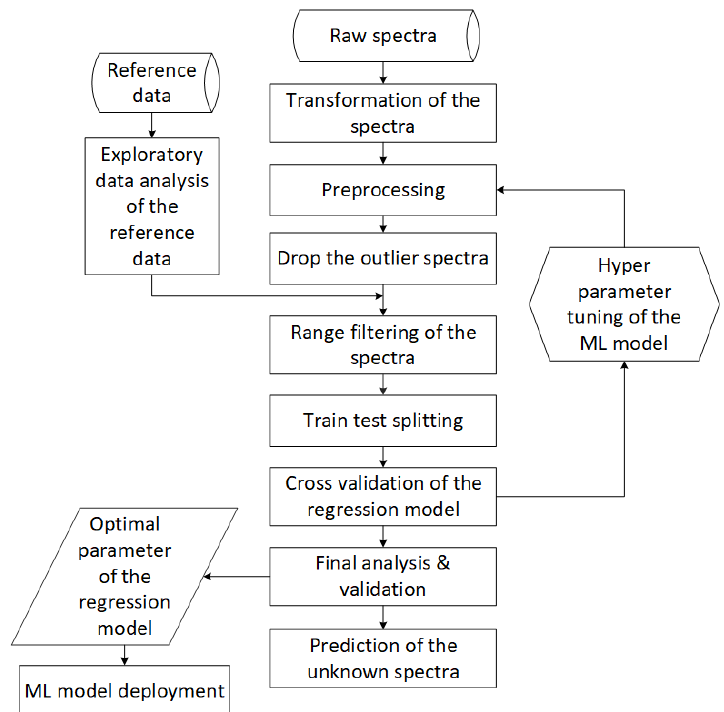
Figure 8. Major stages in the development of ML models. The parts are considered general laboratory, quality assurance and industry independence.